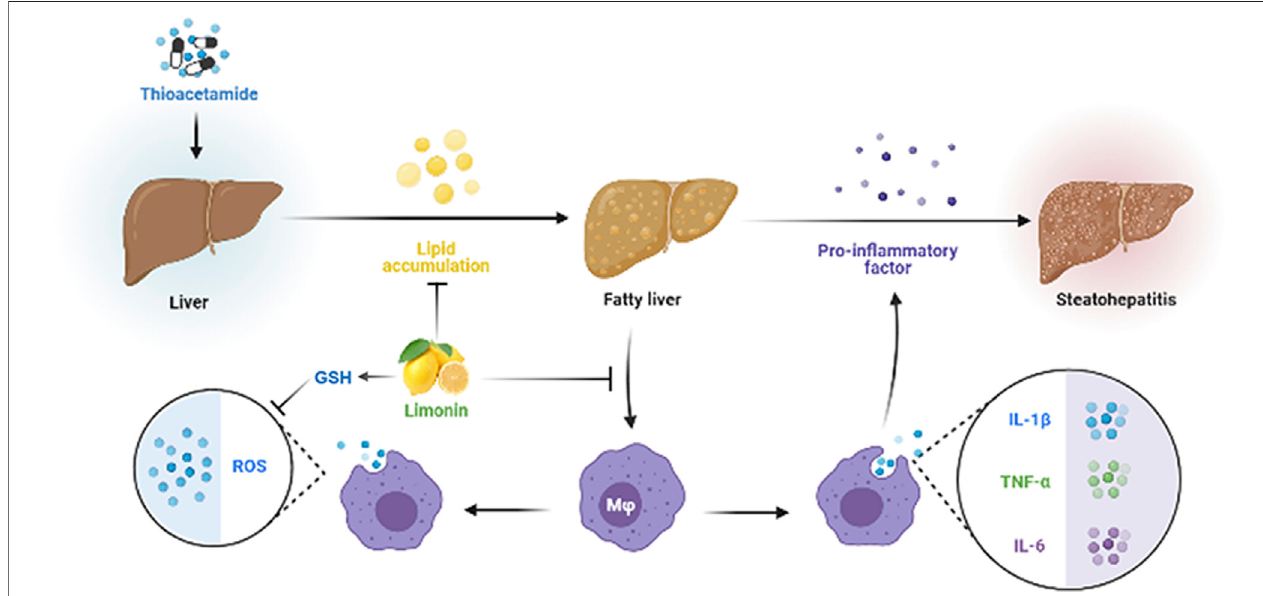
FIGURE 9 | Diagram of the protective mechanism of limonin on non-alcoholic fatty liver